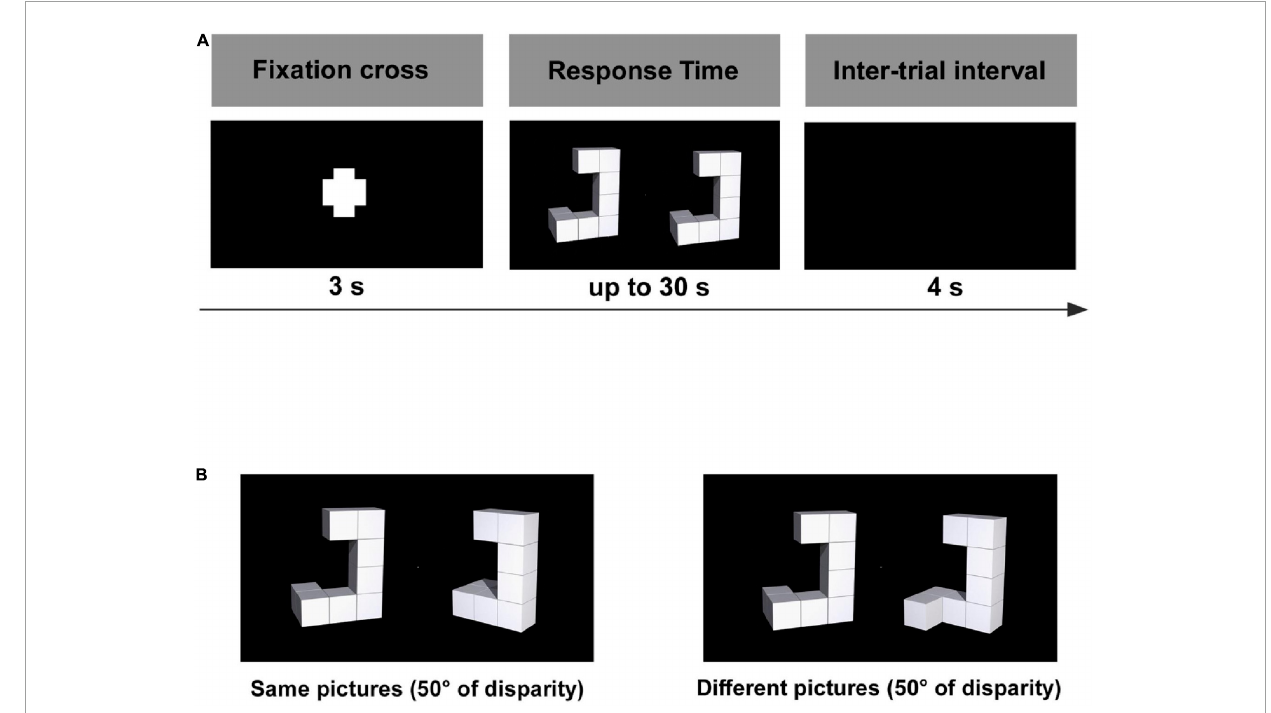
FIGURE1 (A) Experimental design and (B) experimental conditions: same and different stimulus pairs (Anomal et al., 2020).